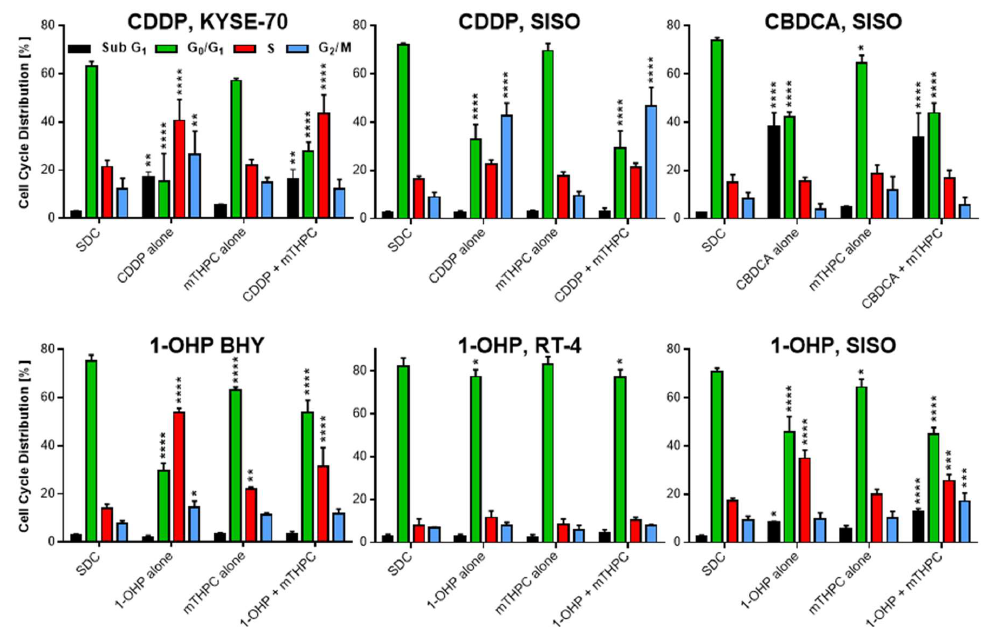
Figure 5. Cell cycle distribution after mTHPC-PDT, treatment with a Pt(II) complex alone or after combination of both treatments in various cell lines. Cells were illuminated 24 h after treatment with a light fluence of 1.8 J/cm 2 and fixed cells were stained with PI 48 h after illumination. Cells were assigned to either subG 1 (fragmented DNA, apoptotic), G 0 /G 1 , S, or G 2 /M phase and compared to a non-illuminated, solvent treated sample (solvent dark control, SDC) that served as a reference in statistical analysis. Data presented as means ± SD from at least three independent experiments. (* p < 0.05; ** p < 0.01; *** p < 0.001; **** p <0.0001).